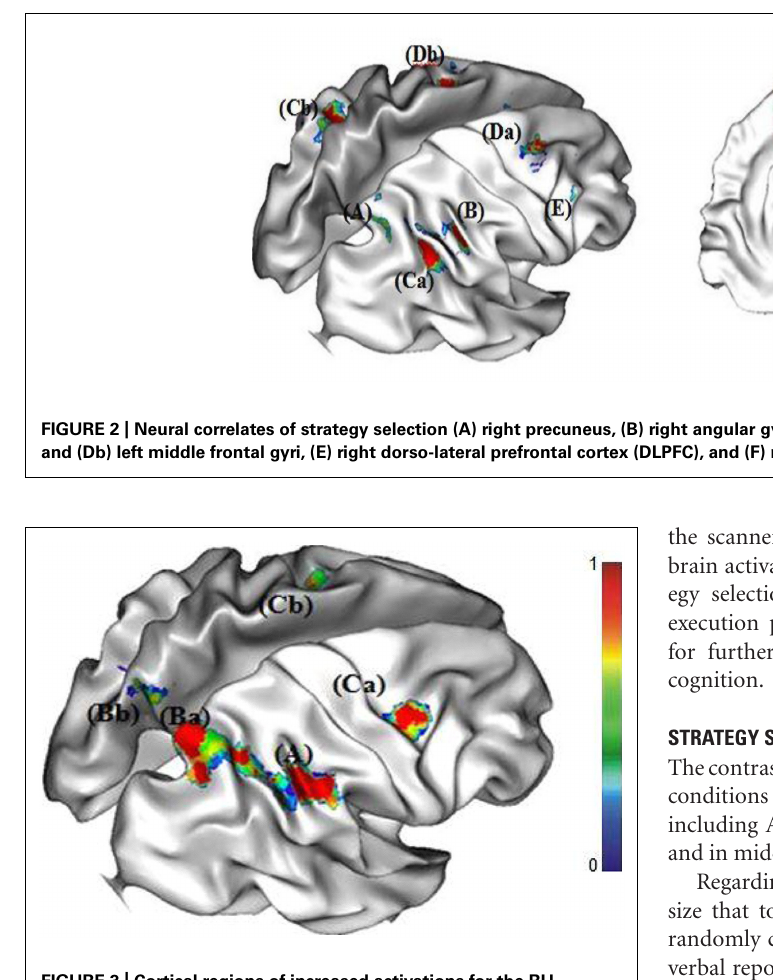
FIGURE 3 | Cortical regions of increased activations for the RU strategy (A) right supramarginal gyrus (SMG), (Ba) right and (Bb) left precuneus, (Ca) right and (Cb) left middle frontal